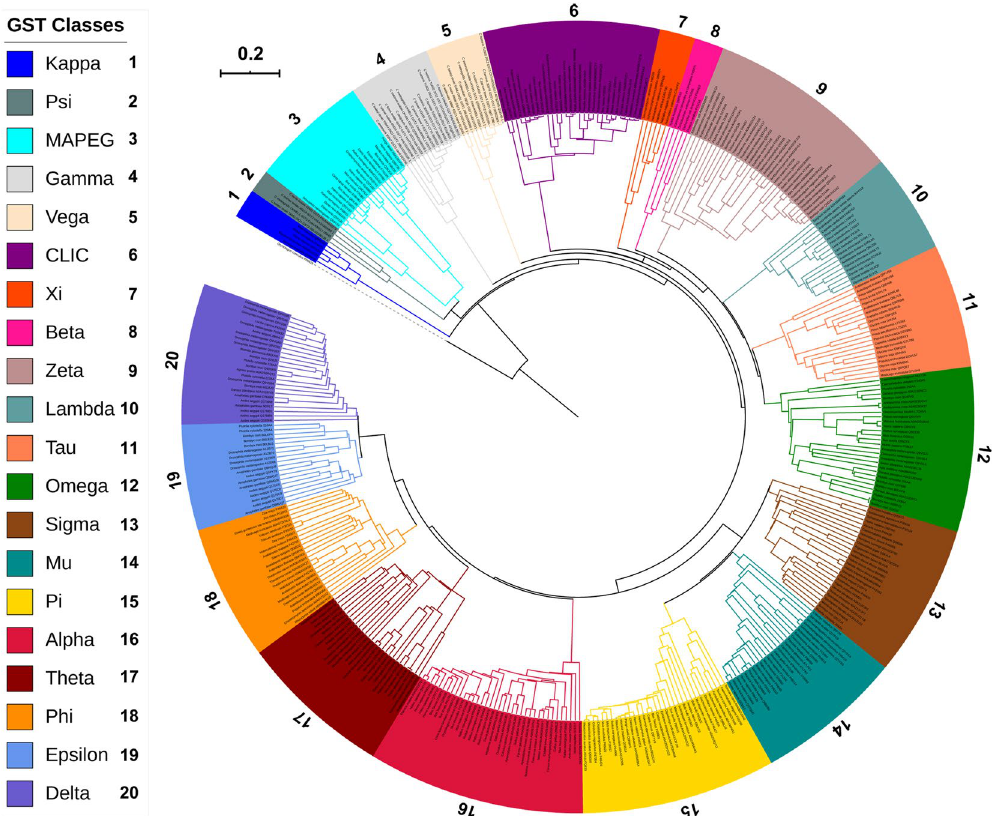
Figure 2. Phylogenetic tree of the glutathione transferases (GSTs) protein sequences of Cryptosporidium species with GSTs from 17 different GST classes. Thioredoxin from Oryctolagus cuniculus (protein ID: P08628) is used as an outgroup. Three new GST classes reported in this study from Cryptosporidium species named Vega, Gamma and Psi are also shown in the tree. A high-resolution phylogenetic tree is provided in Supplementary Dataset